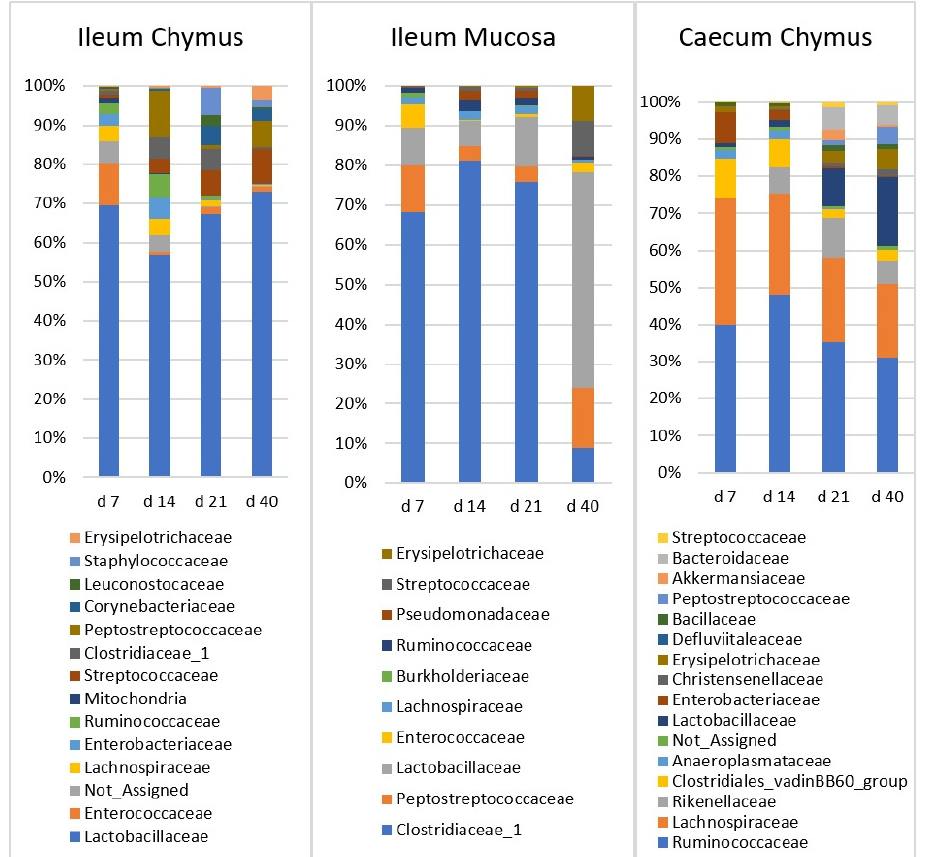
Figure 4. The relative abundance of microbiota at family level in the ileal chymus (IC), ileal mucosa (IM), and caecal chymus (CC) as affected by the age of chickens. Microbial composition at different taxonomical levels and in different intestinal samples (IC, IM, and CC) were compared using two- way ANOVA test with Tukey’s HSD multiple group comparison’s post hoc test, using the dietary treatments (C, Br, and Sy) and the age of birds (7, 14, 21, and 40 day) as main factors. The differences were considered significant at a level of p ≤ 0.05.